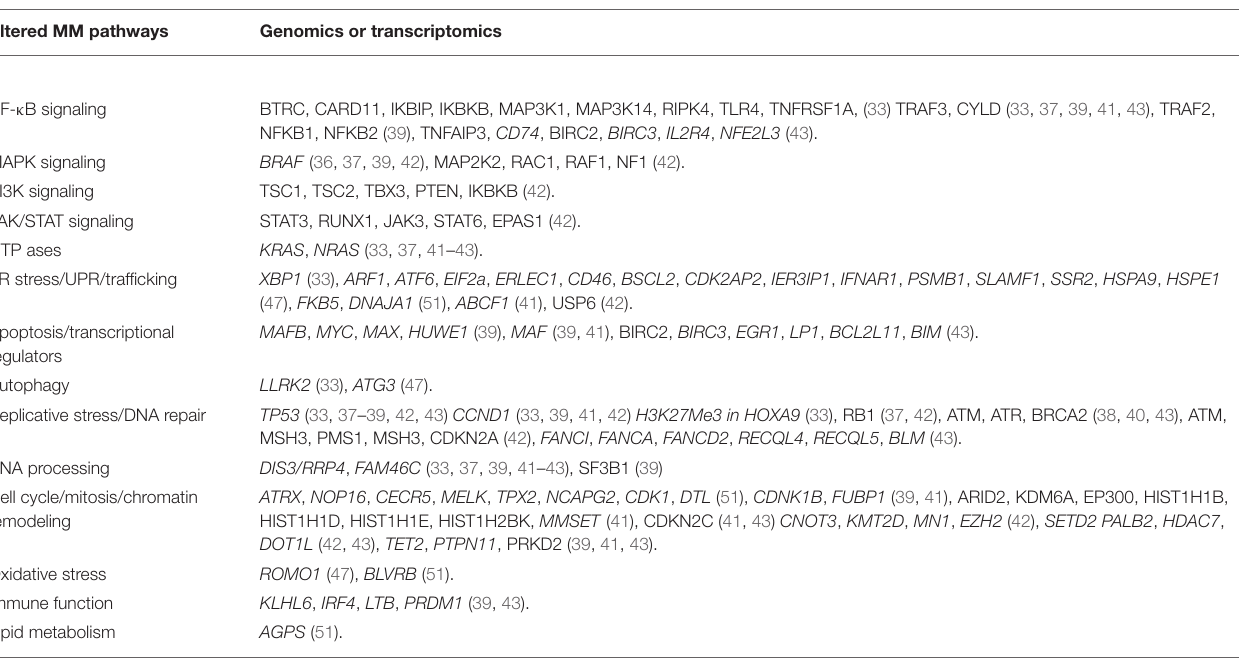
TABLE 1 | List of MM related pathways genes found altered in plasma cell dyscrasias through “OMICS”